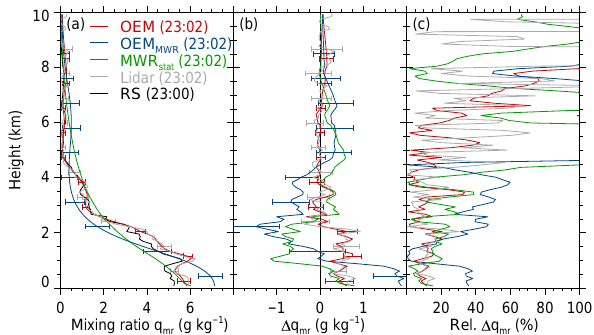
Figure 9. (a) Comparison of mixing ratio profiles on 5 May 2013 around 23:00UTC: retrieved profile (OEM, red), retrieved profile with RS climatology as a priori (OEM MWR , blue), profile from the MWR statistical retrieval (green), the Raman lidar measurement (grey) and RS (black) as reference. Error bars are added to the op- timally estimated profiles (red, blue, grey). Absolute (b) and rela- tive (c) difference from the reference